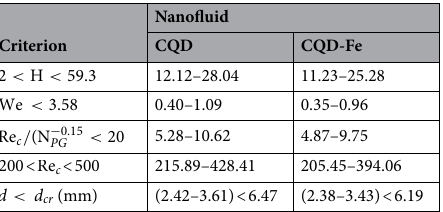
Table 3. The circulating state criteria of drops along with corresponded values 32 .